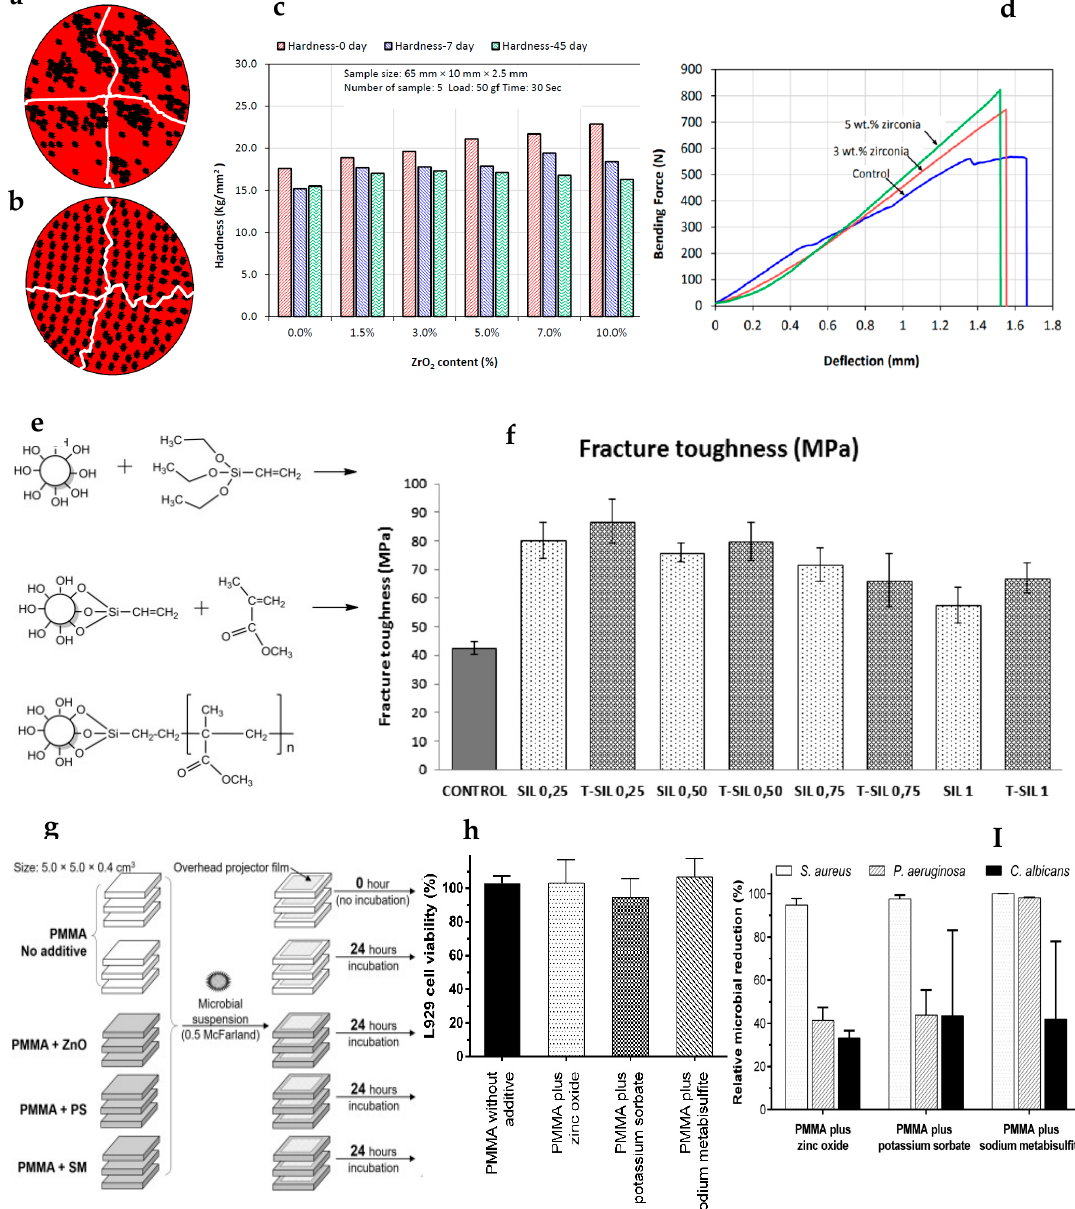
Figure 5. Various representative examples of PMMA modifications and associated outcomes: ( a ) randomly distributed filler particles allowing crack propagation; ( b ) uniformly dispersed particles that enhance fracture toughness through crack diversion [66]; ( c ) impregnation with ZrO 2 resulted in increased Vickers hardness values [51] and ( d ) flexural properties [30]; ( e ) silica nanoparticle surface modification using trietoxyvinylsilane and chemical bonding to MMA to enhance the fracture toughness ( f ) of modified PMMA (from [240] with permission), PMMA (control), PMMA reinforced with silica (SiO 2 ) nanoparticles measuring ~12 nm (PMMA-SIL), and PMMA containing trietoxyvinylsilane-modified SiO 2 nanoparticles (PMMA T-SIL); ( g ) antimicrobial functionalization of PMMA by adding zinc oxide, potassium sorbate (PS), and sodium metabisulfite (SM) (from [241] with permission) showed no remarkable effects on L929 cell viability ( h ), however resulted in a significant antimicrobial action against bacteria and Candida albicans ( I ).